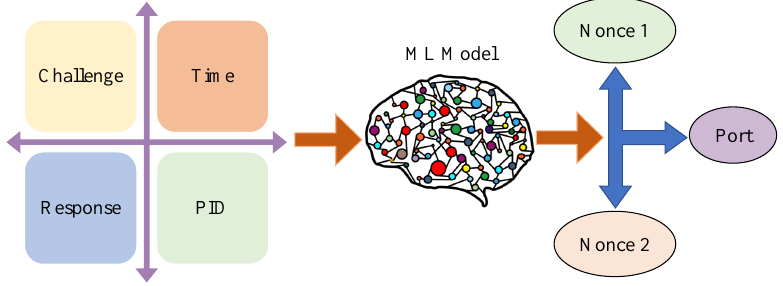
Figure 5. Input and output features of the SML